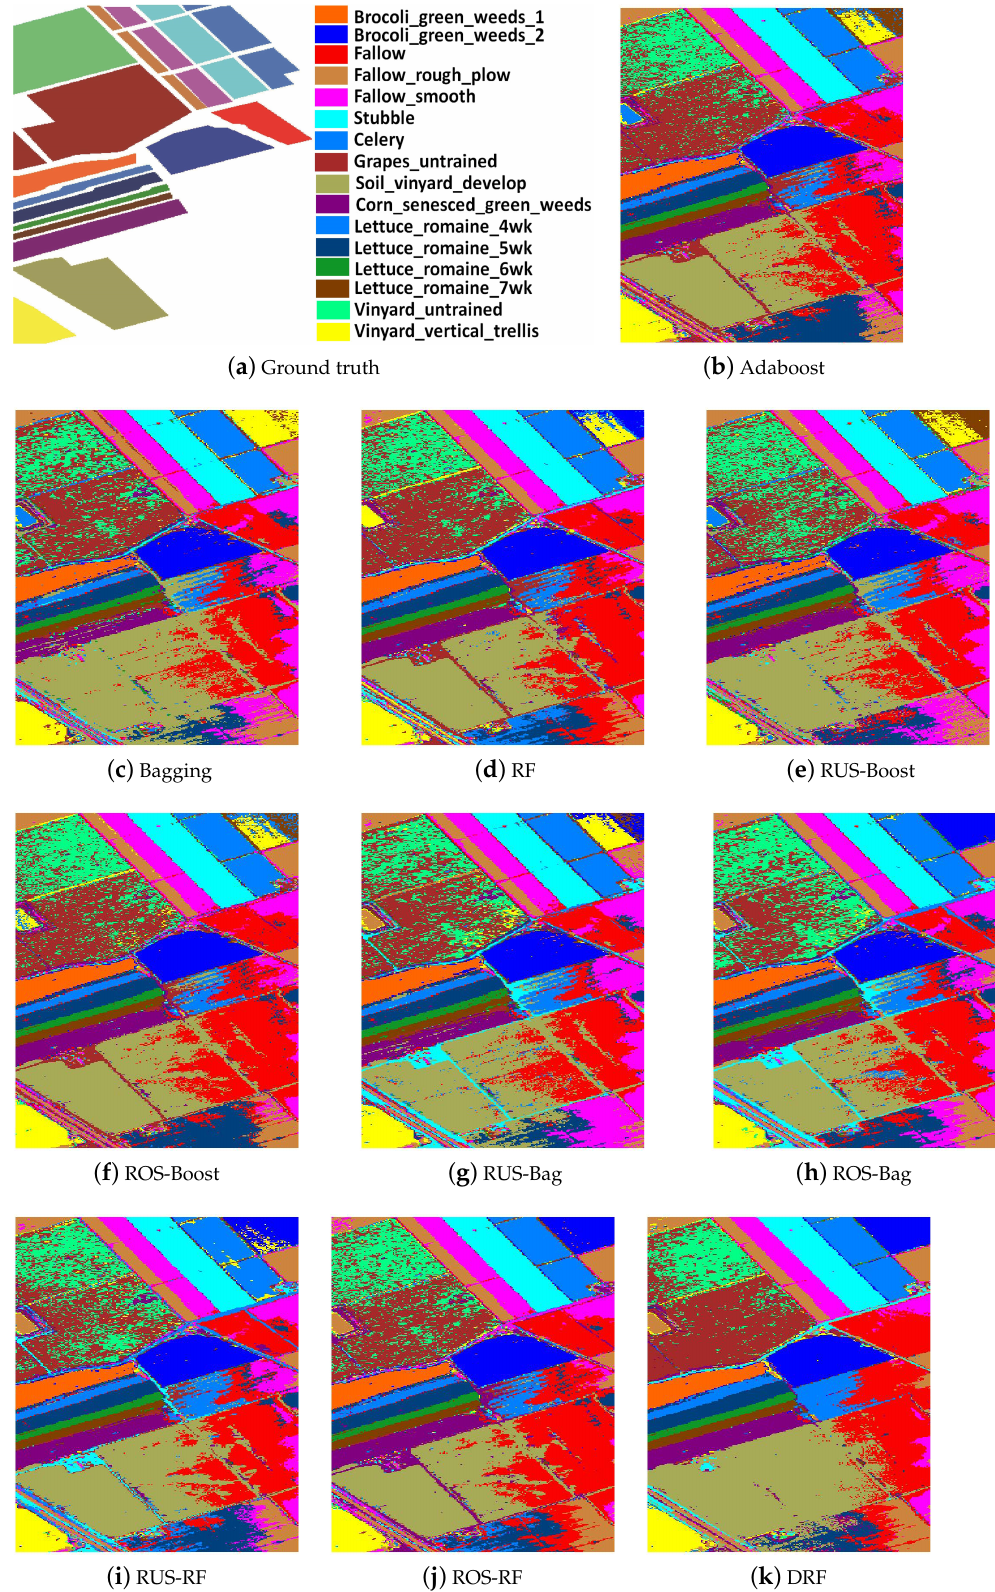
Figure 5. Ground truth, classification maps of Adaboost, Bagging, random forest, random undersam- pling combined, random oversampling combined Adaboost, Bagging, and random forest, and the proposed double random forest DRF, on the hyperspectral data Salinas